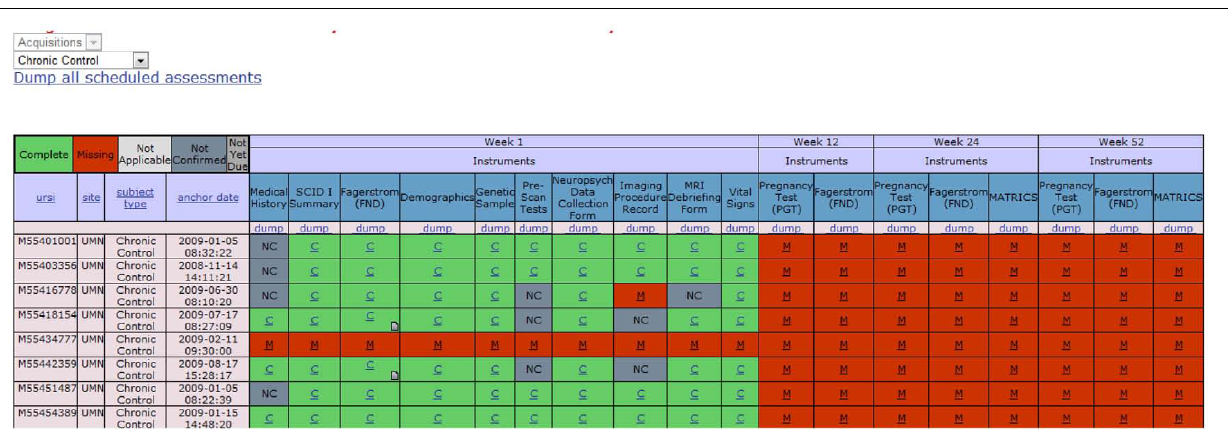
FIGURE 3 | Based on a schedule of events, each subject’s progress is tracked, and a researcher can see the progress at-a-glance . URSI is the unique research study identifier that is unique across all studies; C, the green squares = complete; M, the red squares = missing; NC, the gray squares = not